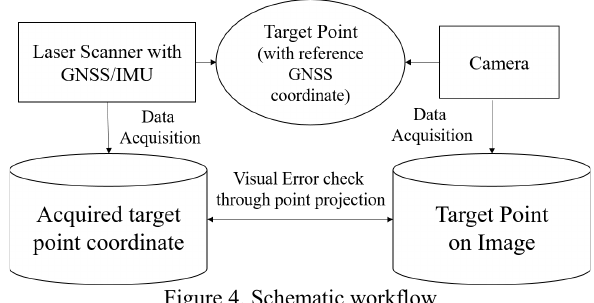
Figure 4. Schematic workflow